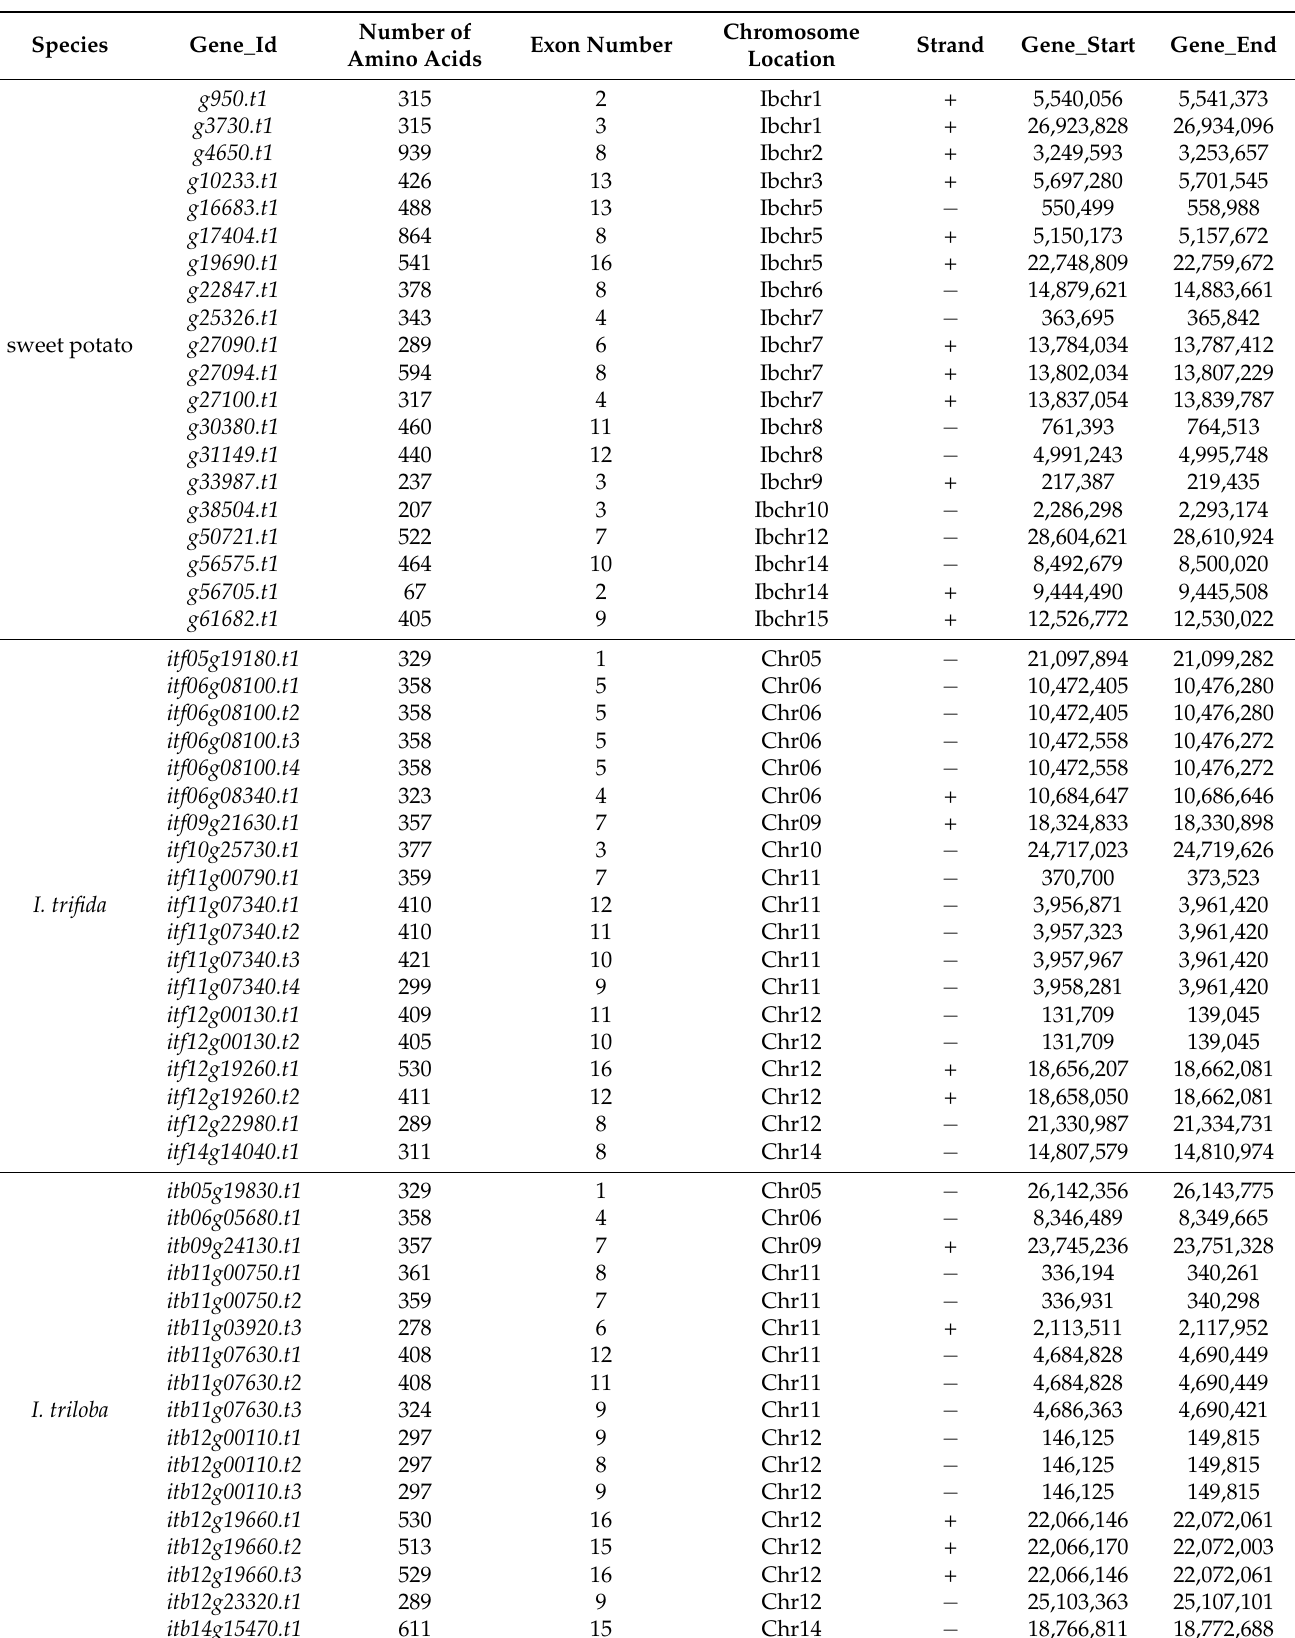
Table 1. The nifH gene information of sweet potato, I. trifida and I. triloba